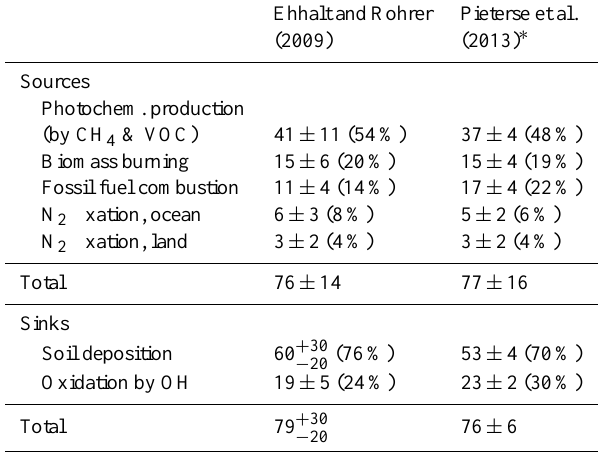
Table 1. Global tropospheric sources and sinks of H 2 in Tg yr − 1 and approximate percentage of the total source or sink in